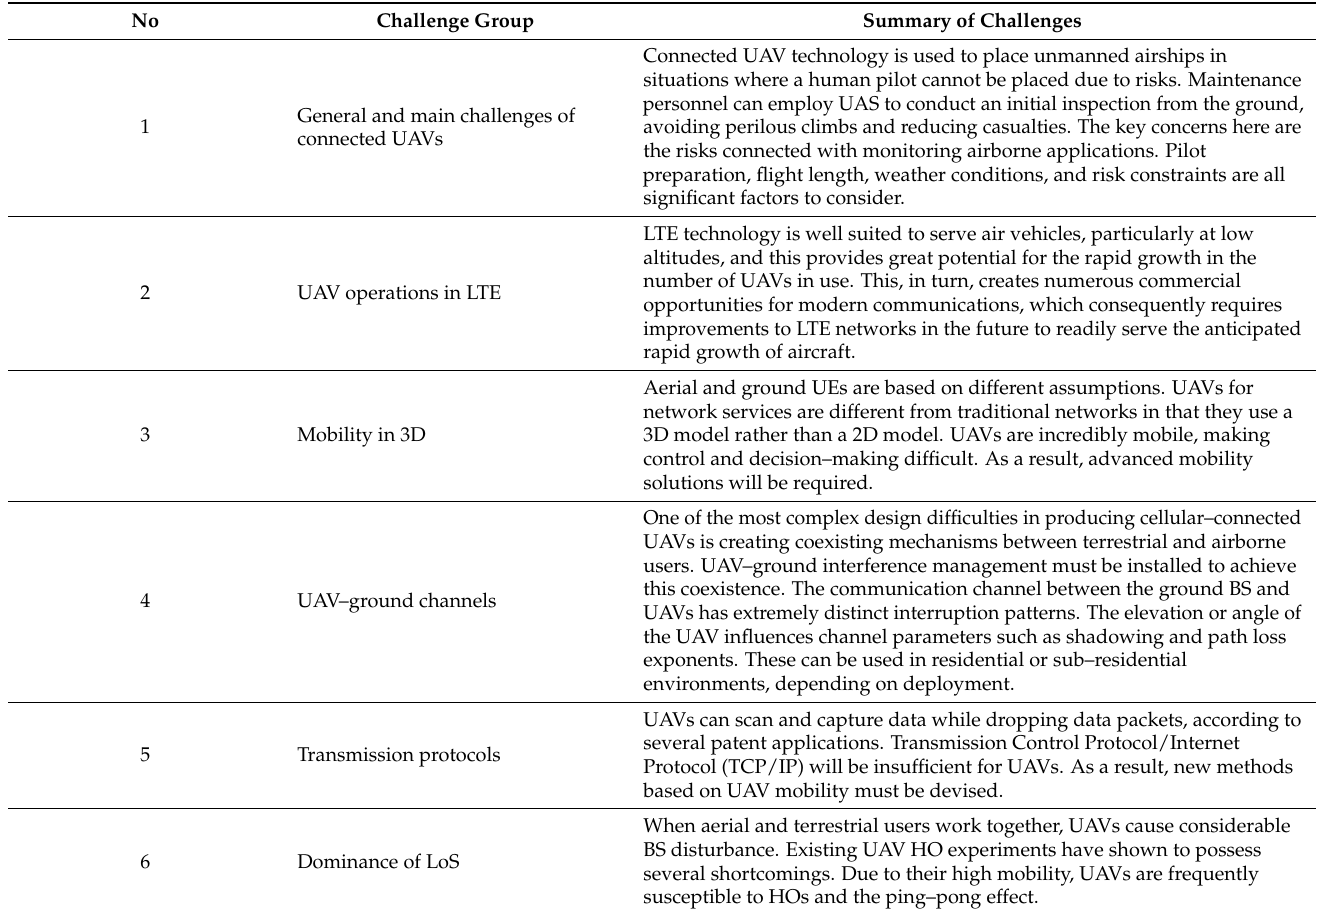
Table 2. Summary of research challenges throughout the